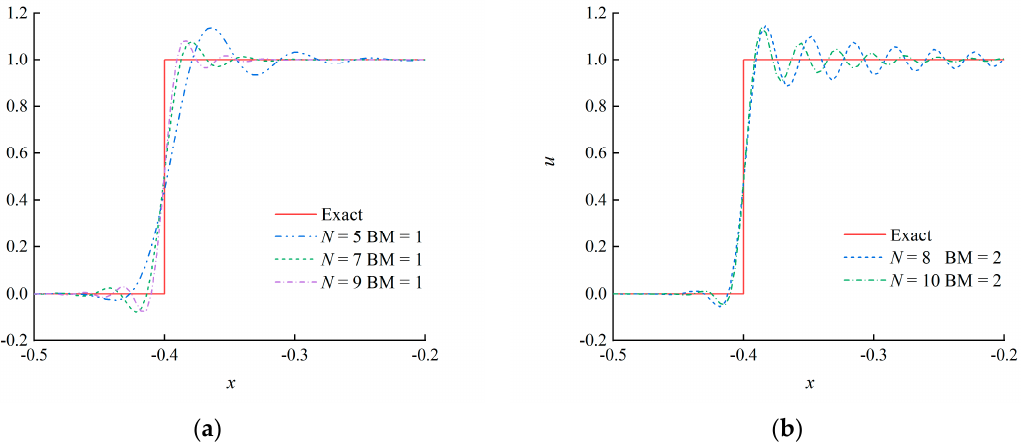
Figure 4. Advection of a square wave by the different schemes at t = 32, J = 8: ( a ) N ∈ odd; ( b ) N ∈ even.